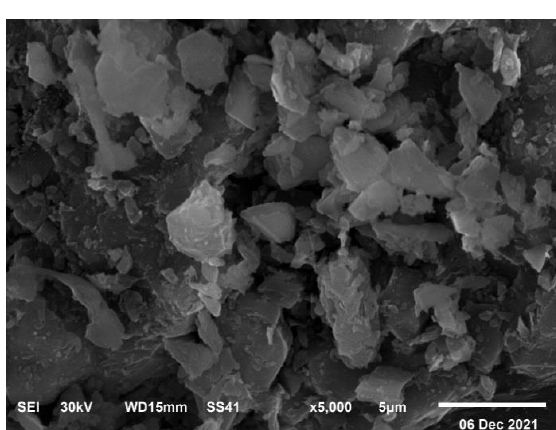
Figure 6. SEM image of VA particles.